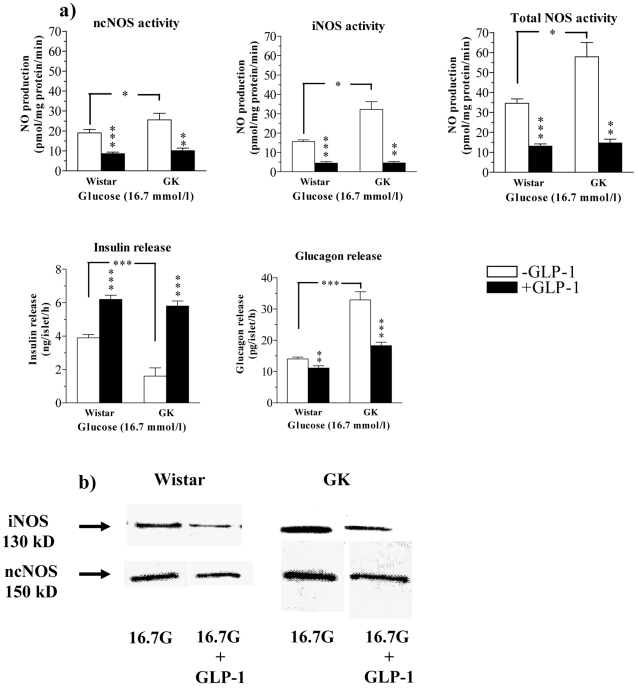
(a) NOS activities and hormone secretion in islets incubated at high glucose. Islet NO-production from ncNOS, iNOS and total NOS as well as insulin and glucagon release from islets of Wistar or GK rats incubated at 16.7 mmol/l glucose in the absence (open bars) and presence (dark bars) of 100 nmol/l GLP-1. Values are mean±s.e.m for 6–10 batches of islets at each point. *P<0.05; ** P<0.01; *** P<0.001. (b) Representative examples of Western blots of iNOS and ncNOS protein in the absence and presence of GLP-1 are shown.